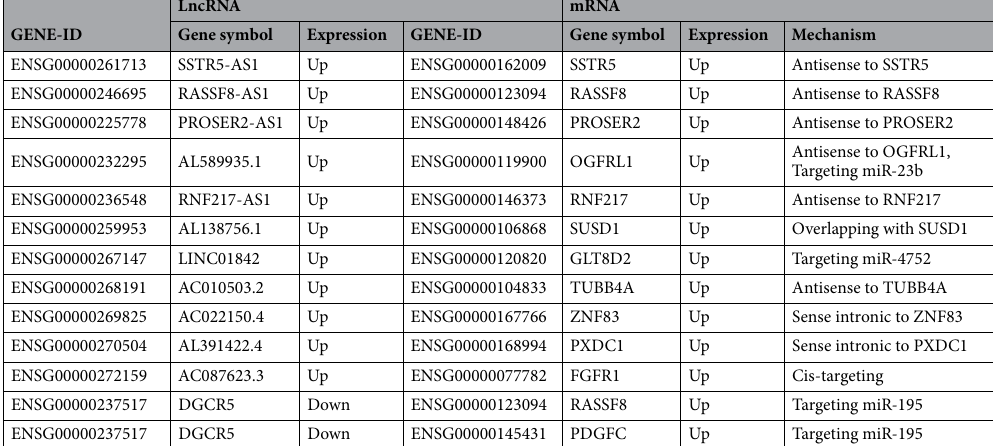
Table 1. Interaction network of the co-expressed DElncRNAs and their target DEGs. Expression level shows the expression in mtKRAS versus wtKRAS.